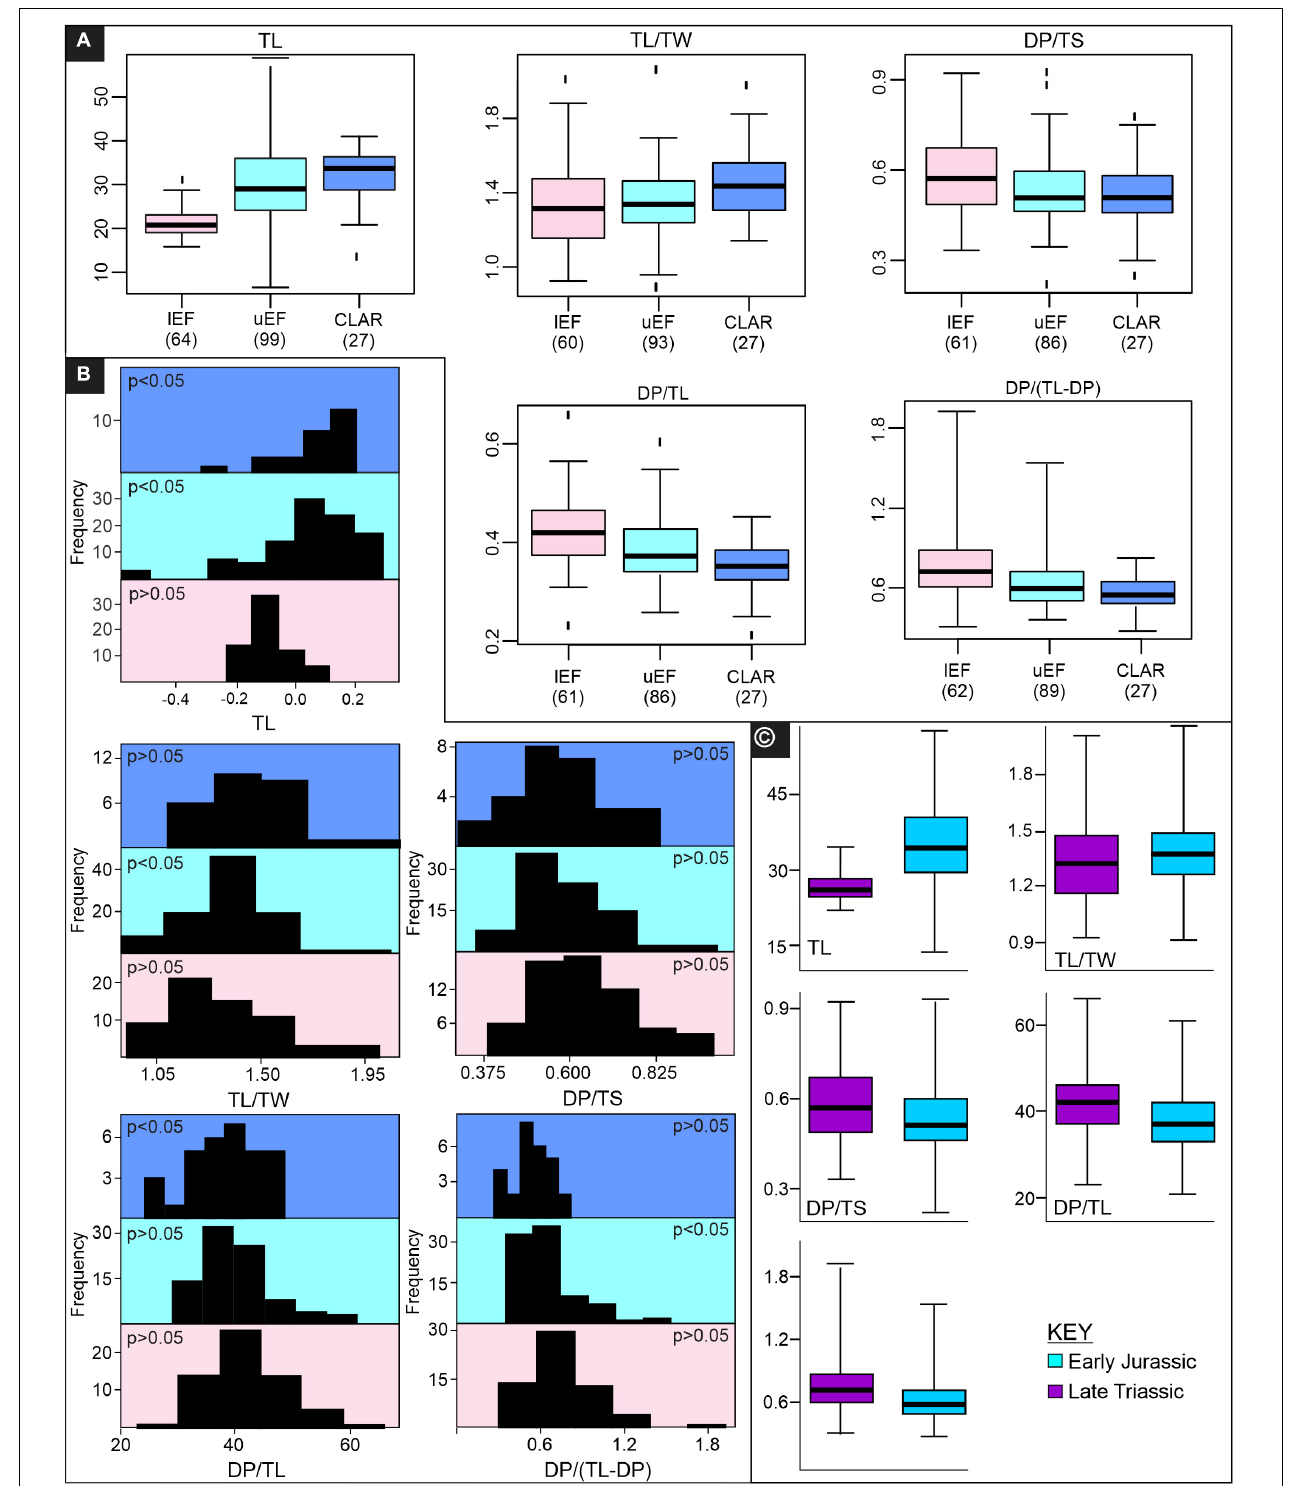
FIGURE 5 | Track length and bivariate ratio trends across the upper Stormberg Group. (A) Boxplots showing the spread in data for considered variables (50% of data within the box, median denoted with a black bar), (B) Frequency distributions with Shapiro-Wilk normality probabilities ( p > 0.05 follows a normal distribution) are included, (C) Box and whisker plots of Late Triassic (lEF) and Early Jurassic (uEF and CLAR) tracks, where 50% of the data are within the box and the median is denoted by a black bar. lEF – lower Elliot Formation, uEF – upper Elliot Formation, CLAR – Clarens Formation, TL – track length, TW – track width, DP – digit III projection, TS – track